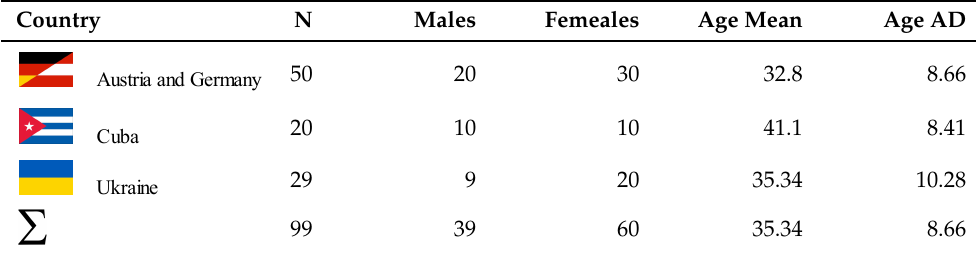
Table 1. Sample’s demographic distrbution of age and